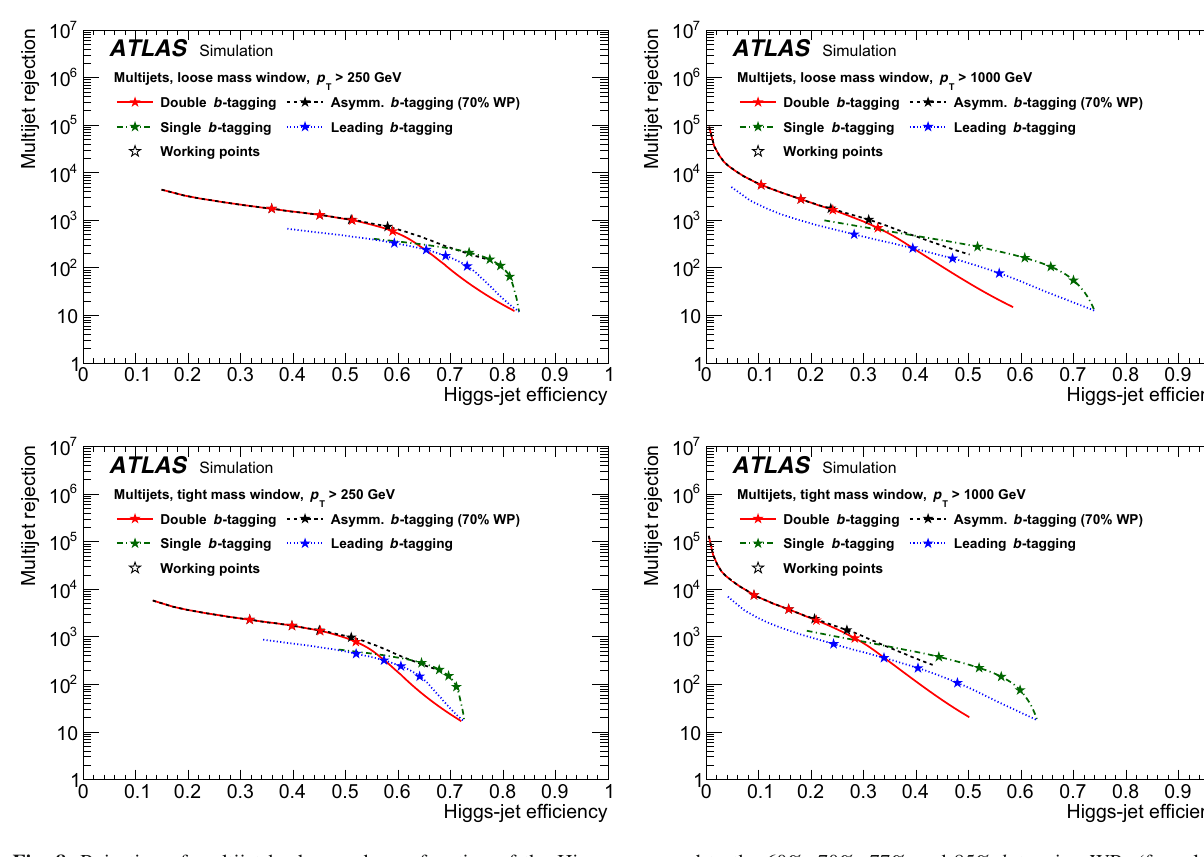
well as their sum in quadrature (total uncertainty) are shown. ‘Jet Scale’ refers to the sum in quadrature of the jet energy and mass scale uncer- tainties and ‘Jet Resolution’ refers to the sum in quadrature of the jet energy and mass resolution